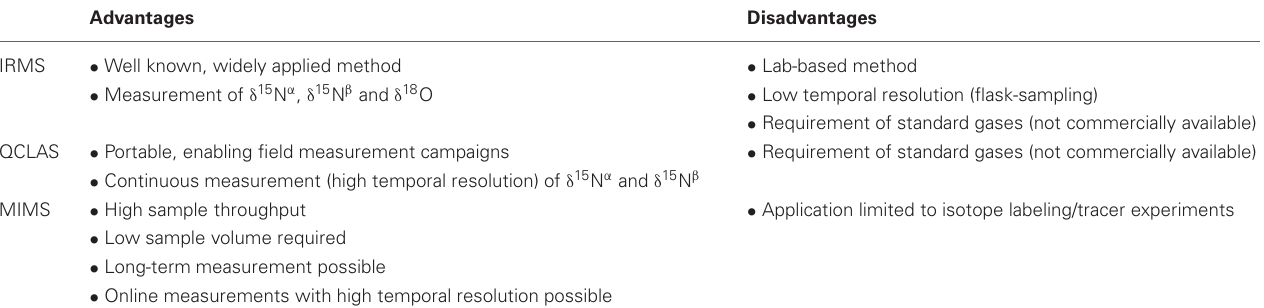
Table 2 | Advantages and disadvantages of isotope-ratio mass spectrometry (IRMS), quantum cascade laser absorption spectroscopy (QCLAS) and membrane-inlet mass spectrometry (MIMS) adapted from Baggs